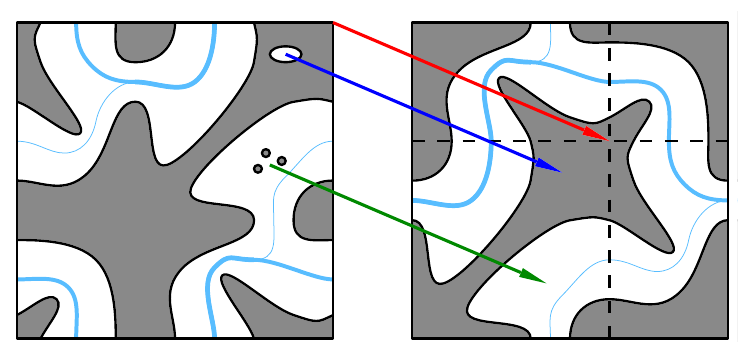
Figure 2. Illustration of the filtering process. Red arrow: a unit cell of the periodic structure is chosen so that obstruction of fluid flow (light blue for a horizontal gradient) at side boundaries is minimized. Blue arrow: enclosed liquid is removed. Green arrow: Small solid particles are removed.